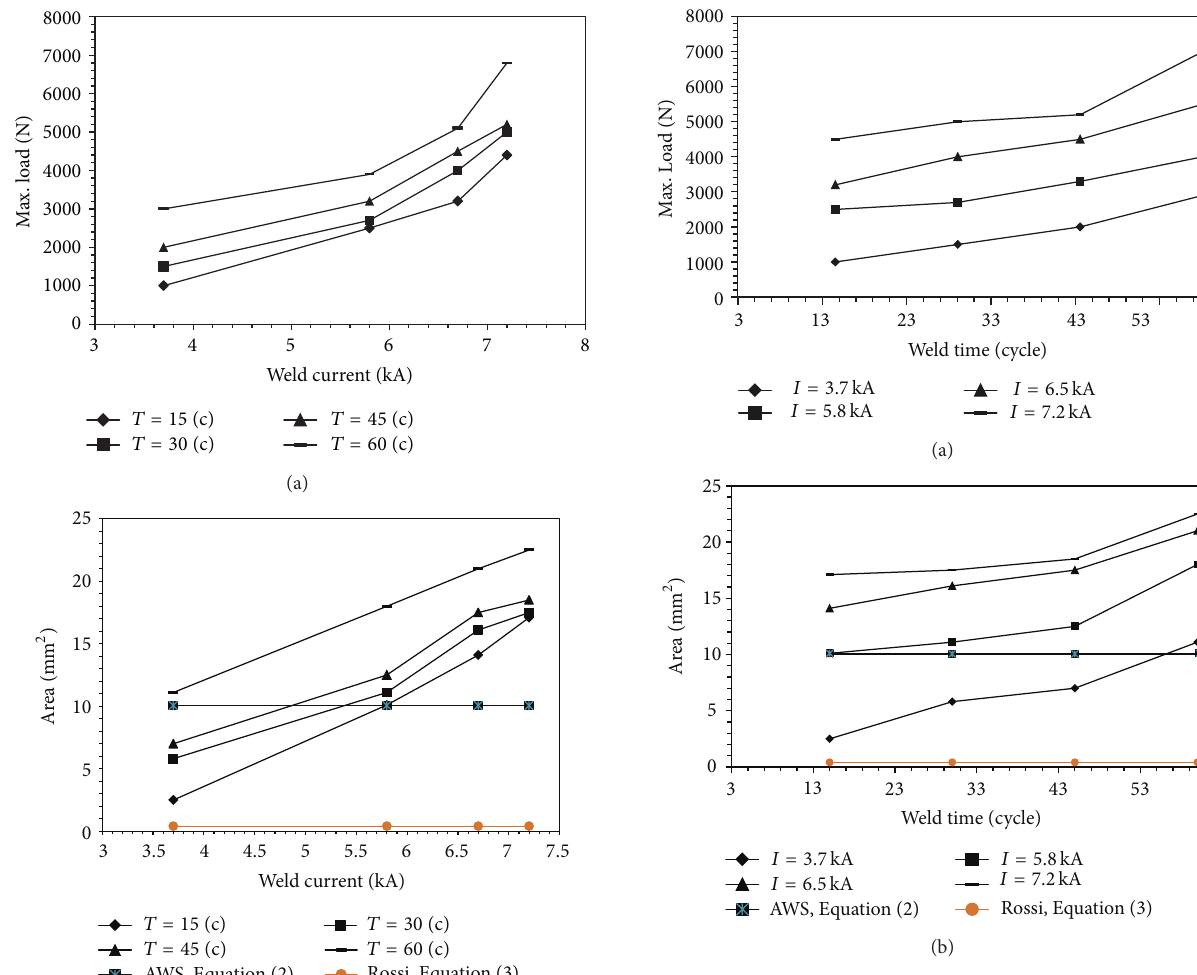
Figure 3: Effect of time of the lap joints, 𝑑 (a) tensile strength; (b) weld nugget = 4 mm, 𝑡 = 0.8 mm; el